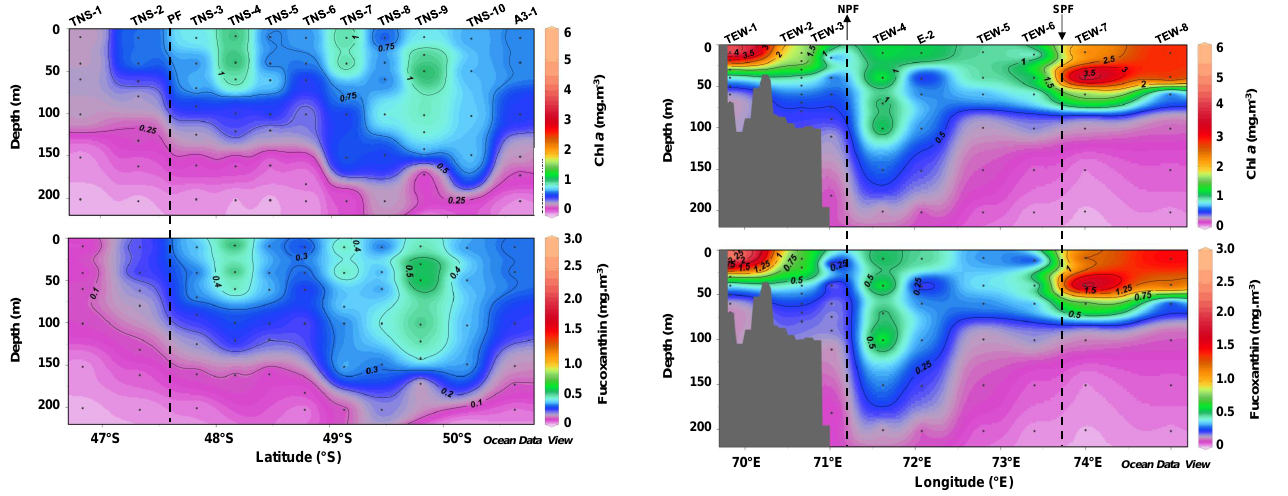
Figure 4. Figure 4. Vertical distribution of total chlorophyll a (chl a ) and fu- coxanthin concentrations along the TEW transect. The dashed lines represent the approximate location of the southern branch of the polar front going to the north (NPF) and to the south